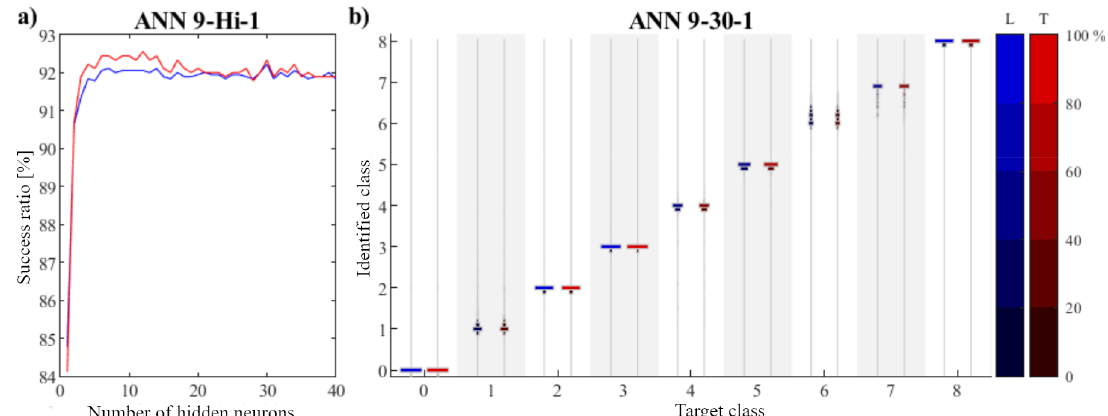
Figure 9. ( a ) Optimization of ANN architecture (9-H-1 ANNs for determination of the type of damage), ( b ) classification results using ANNs with the architecture 9-30-1; adopted classes: S00: 0, S33: 1, S22: 2, S23: 3, S44: 4, S34: 5, S14: 6, S11: 7, S12: 8.